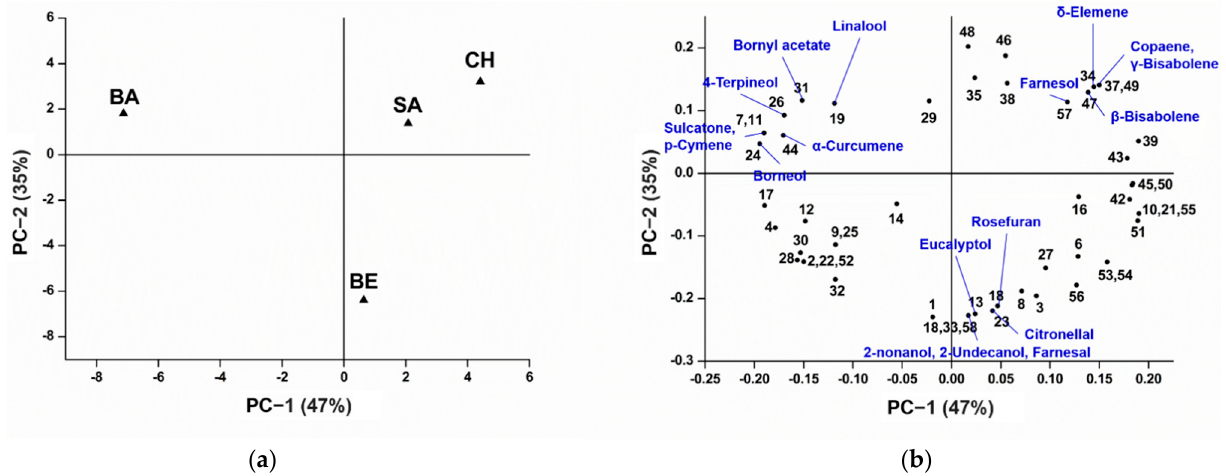
Figure 2. Principal component analysis of 58 secondary compounds in the analyzed Z. officinale oils. ( a ) Score plot and ( b ) loading plot . Z. officinale varieties: Bentong (BE), Cameron Highlands (CH), Sabah (SA), Bara (BA). The peak numbering refers to Table S1.